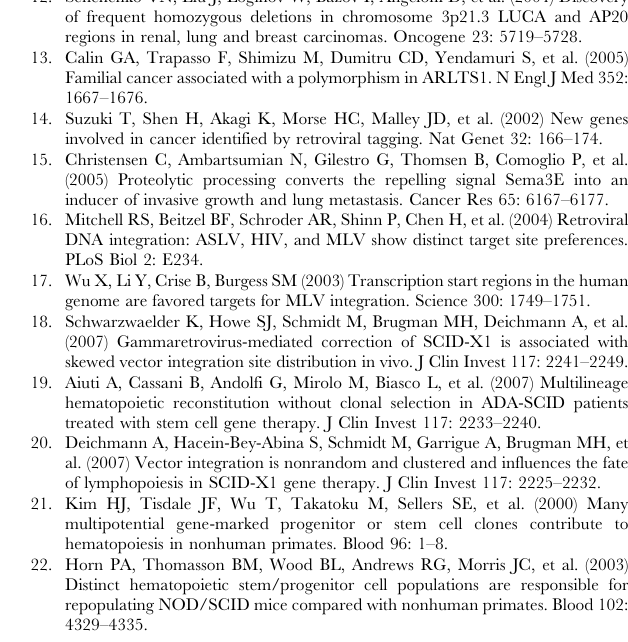
Table S1. b -actin gene number was used as a comparative